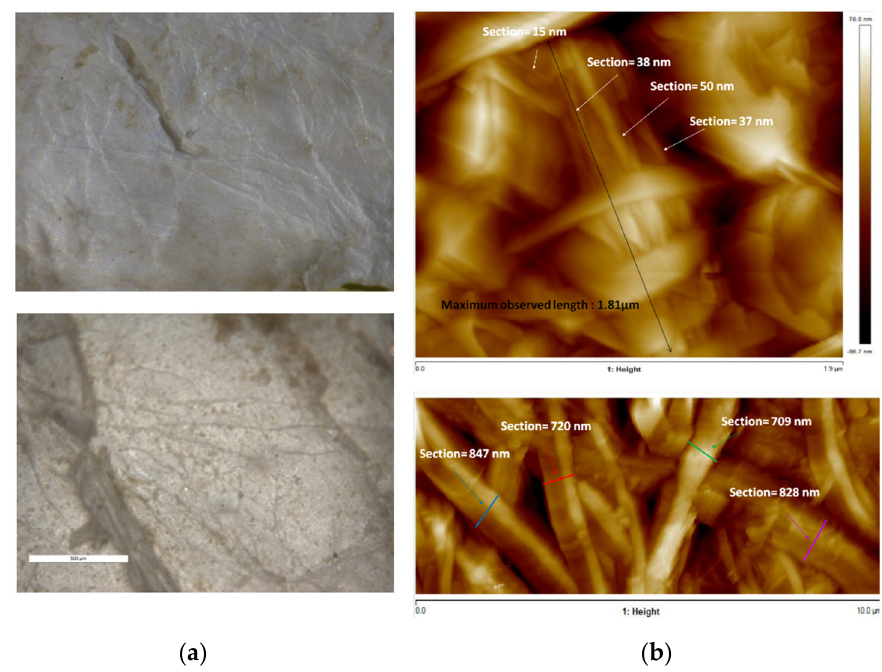
Figure 2. Optical microscopy images of the inner surface of native tunics ( a ) and atomic force microscopy images of the tunic interior ( b ).